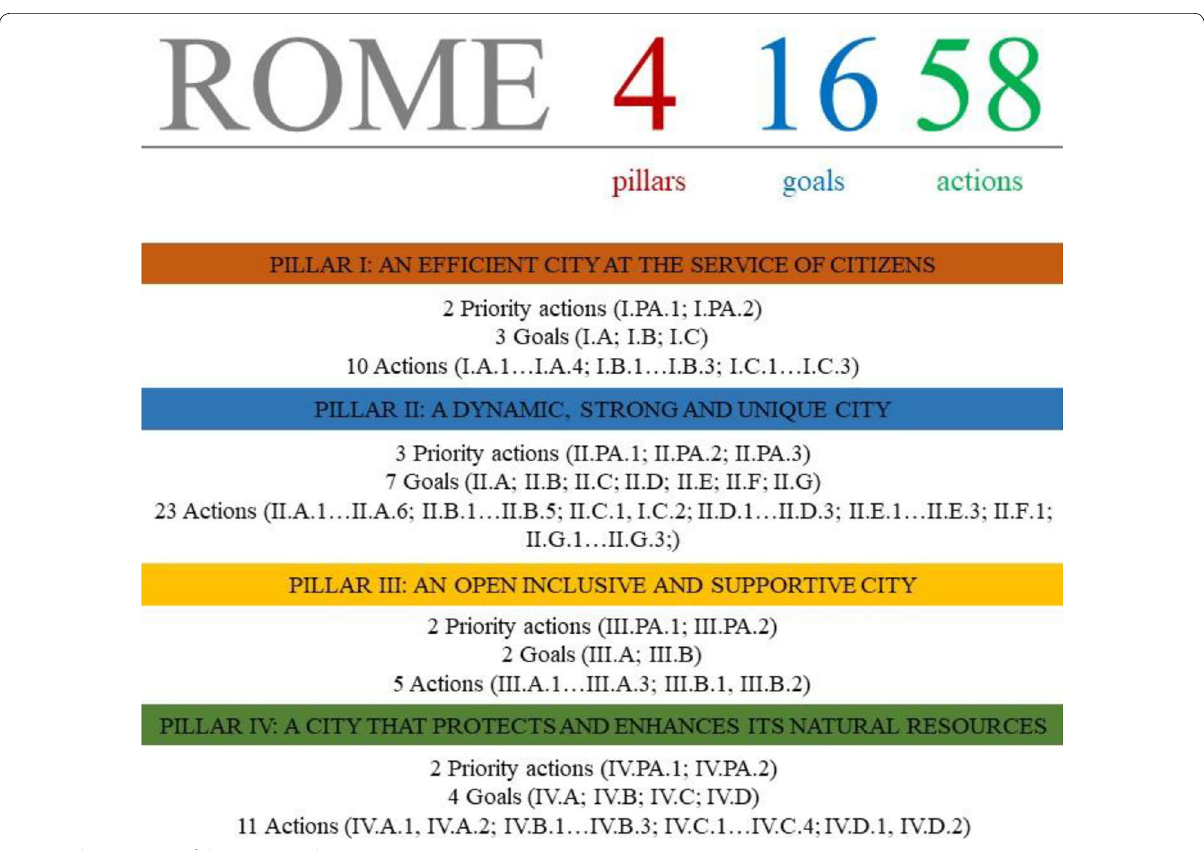
Fig. 7 The structure of the Rome Resilience